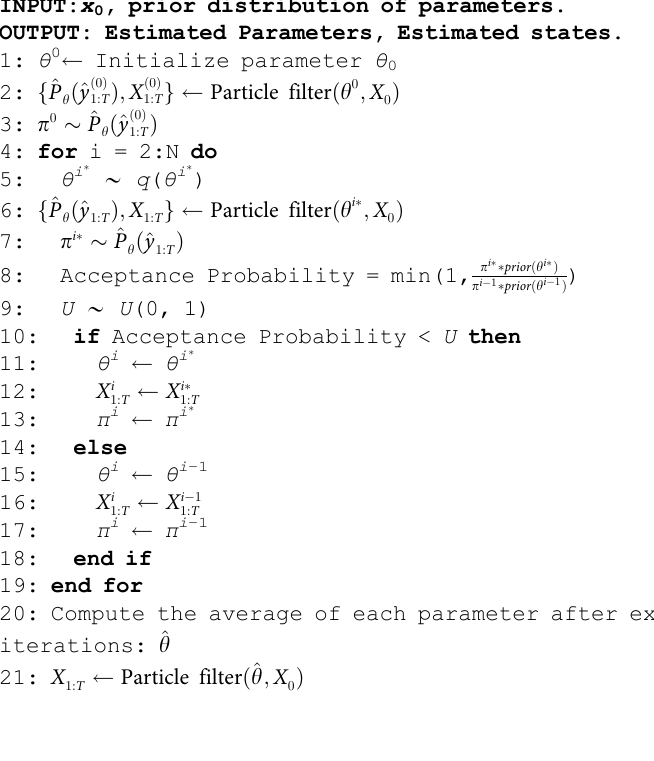
Algorithm 2 Particle Independent Metropolis